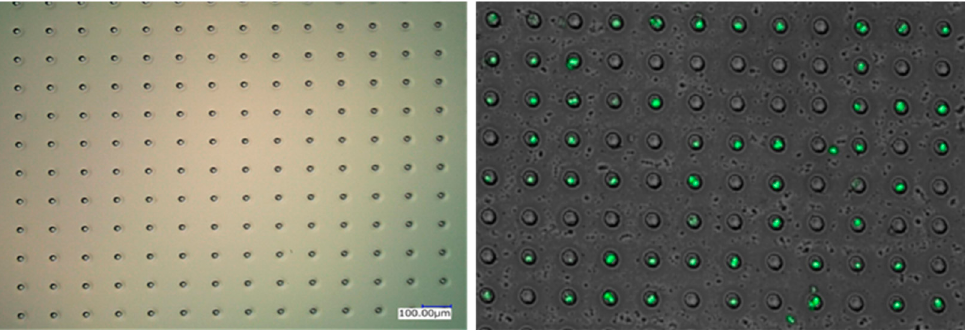
Table 1. Evaluation of different occupancy efficiency.